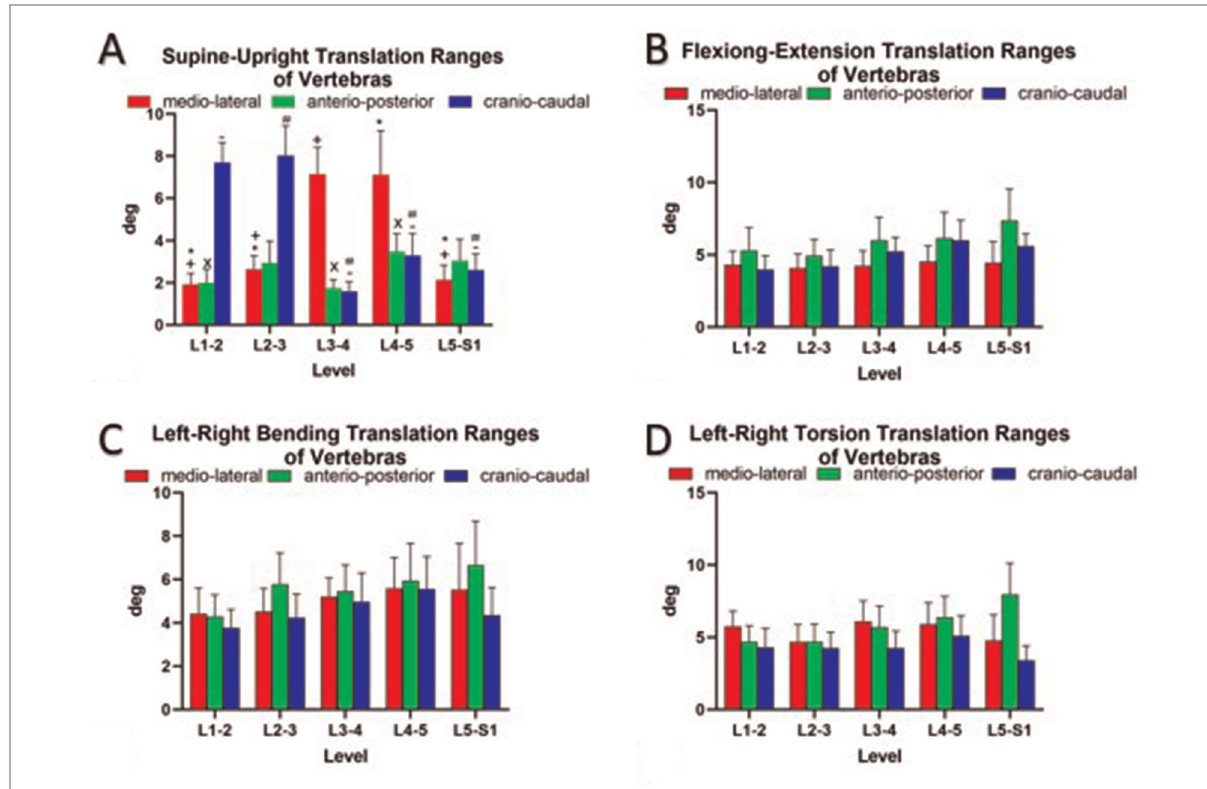
FIGURE 5 Ranges of vertebral translations of asymptotic volunteers ( A ) standing up and along three principal axes under ( B ) fl exion – extension, ( C ) bending, and ( D ) torsion of the trunk. The symbols (*, +, x, #, − ) represent statistical signi fi cance on between-level comparison ( P